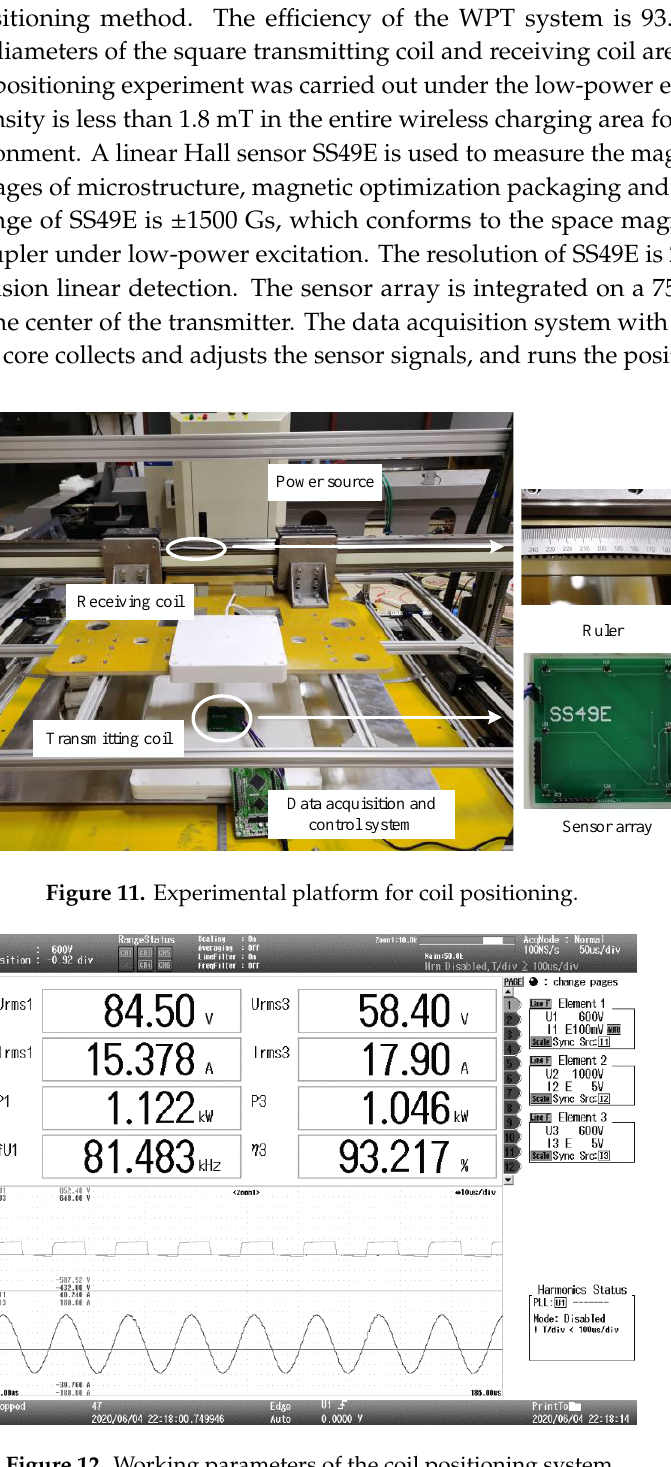
Figure 12. Working parameters of the coil positioning system.